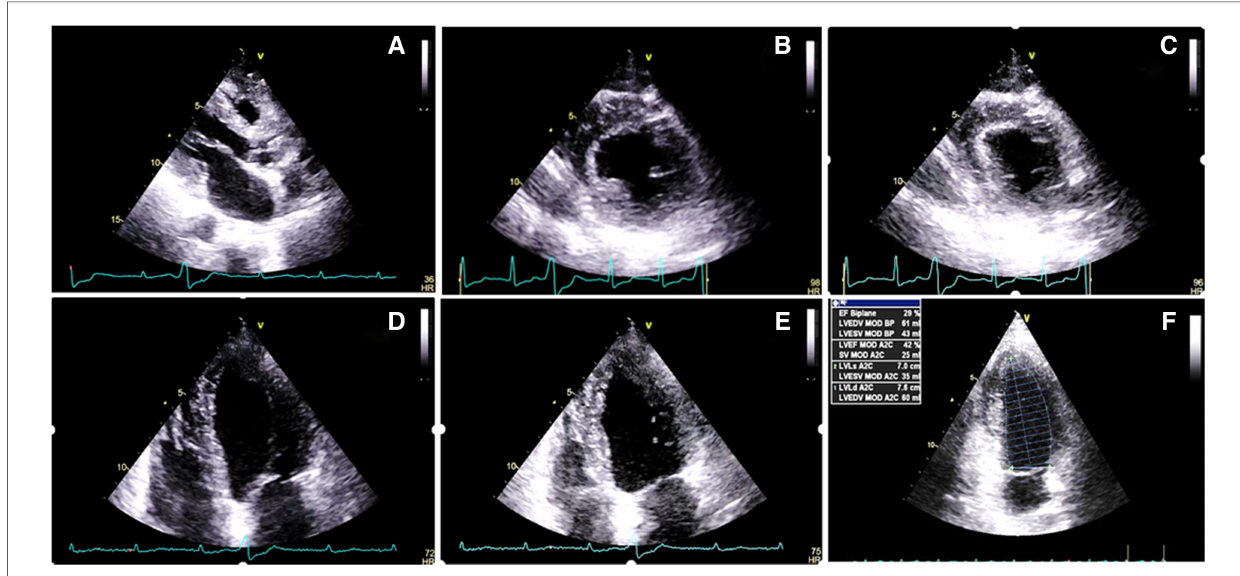
FIGURE 3 Two-dimensional transthoracic echocardiography 1 month after the radiotherapy course ( A – F ), illustrating a marked increase in the thickness of the left and right ventricular walls (15 and 7 mms, respectively), in addition to severe left ventricular systolic dysfunction. ( A ) PLAX view. ( B ) PSAX in the end- diastole. ( C ) PSAX in the end-systole. ( D ) A4C view in the end-diastole. ( E ) A4C view in the end-systole. ( F ) LV EF=28% by Simpson ’ s method. PLAX, parasternal long axis view; PSAX, parasternal short axis view; A4C, apical four chamber view.